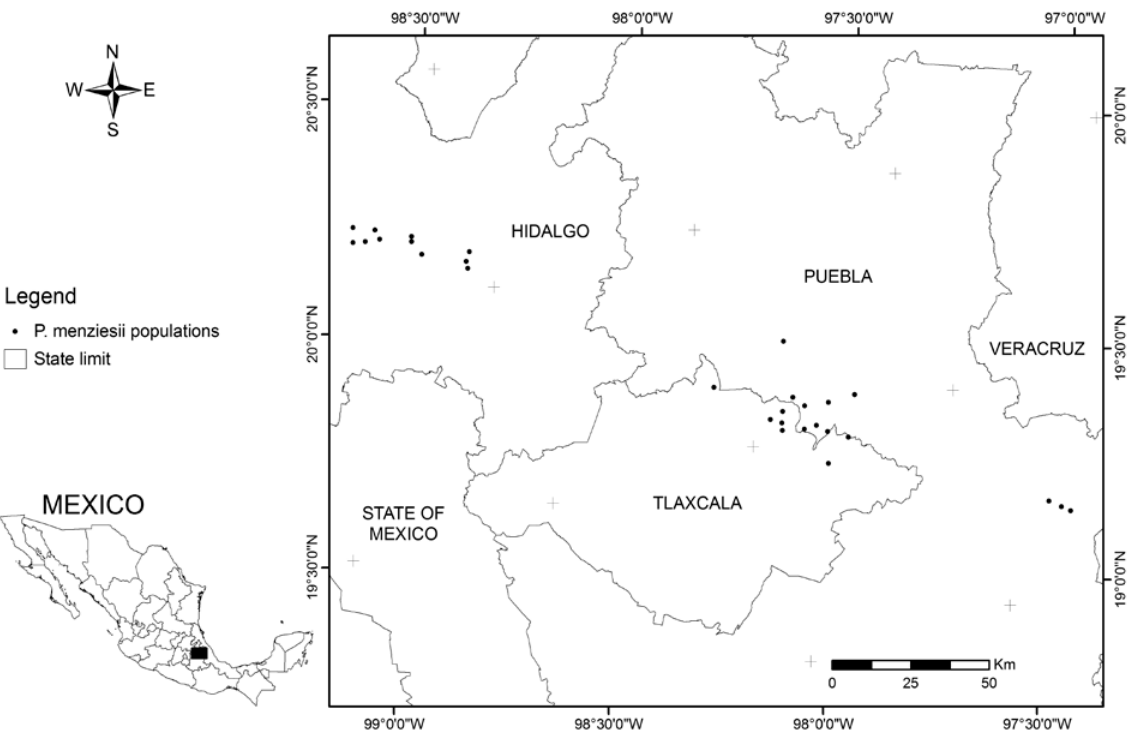
Figure 1. Geographical location of Pseudotsuga menziesii (Mirb.) Franco populations in central